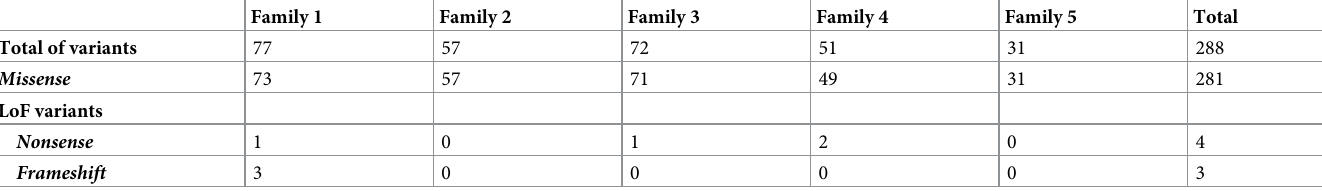
Table 3. Types of rare non-synonymous heterozygous variants co-segregating in both affected relatives of the five melanoma-prone families.